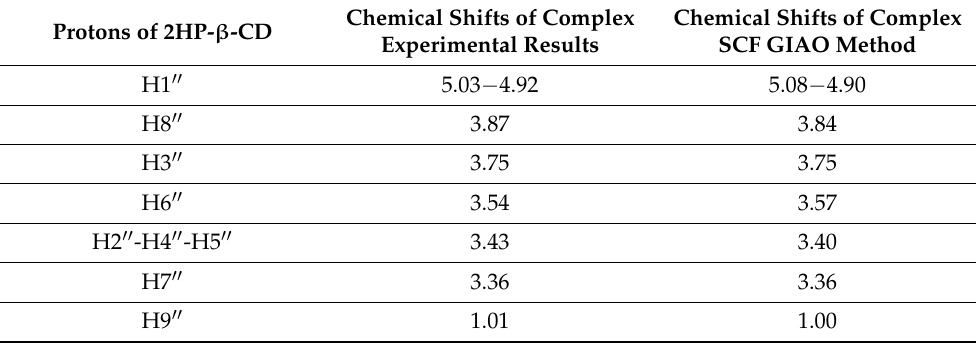
Table 4. 1 H NMR chemical shifts using the SCF GIAO method and experimental results for the HP- β -CD in the complex. Chemical Shifts of Complex Protons of 2HP- β -CD